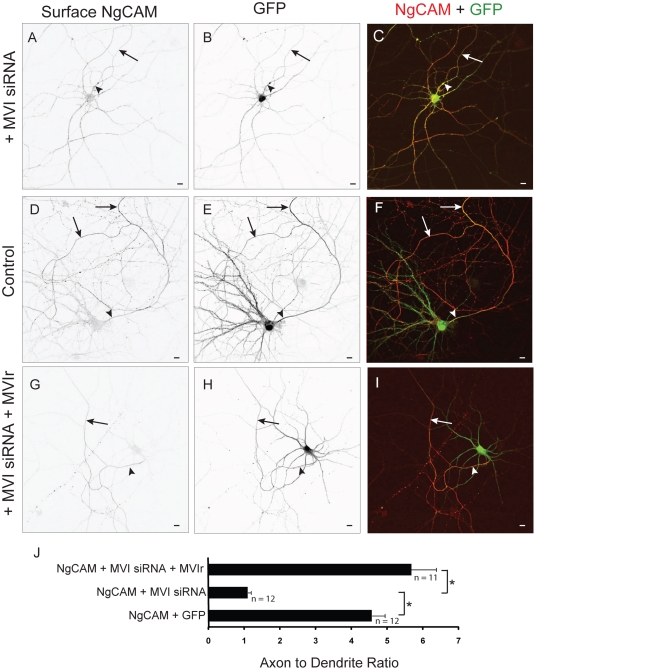
Knockdown of Myosin VI with siRNA blocks axonal enrichment of NgCAM.In a cortical neuron transfected with siRNA against Myosin VI (MVI siRNA), surface exogenous NgCAM (A) localized both to axons and to dendrites, with an expression pattern that overlaps that of GFP (B). (C) Merge of surface NgCAM (red) and GFP (green) in a cell coexpressing MVI siRNA. In contrast, NgCAM (D) was enriched on the surface of the axon when expressed with GFP (E). (F) Merge of surface NgCAM (red) and GFP (green). When expressed with both siRNA against Myosin VI and a version of Myosin VI that is impervious to siRNA (MVIr), surface NgCAM (G) localized specifically to the axon, in contrast to the nonspecific localization of GFP (H). (I) Merge of surface NgCAM (red) and GFP (green) in a cell cotransfected with MVI siRNA and MVIr. (J) When coexpressed with either GFP alone or with MVI siRNA and MVIr, NgCAM localized to the axon with an ADR 4- to 5-fold higher than when NgCAM was coexpressed with MVI siRNA alone. Arrows point to the axon; arrowheads point to the axon initial segment. Scale bars are 10 µm. *, p<0.0001 (Wilcoxon-Mann-Whitney test).